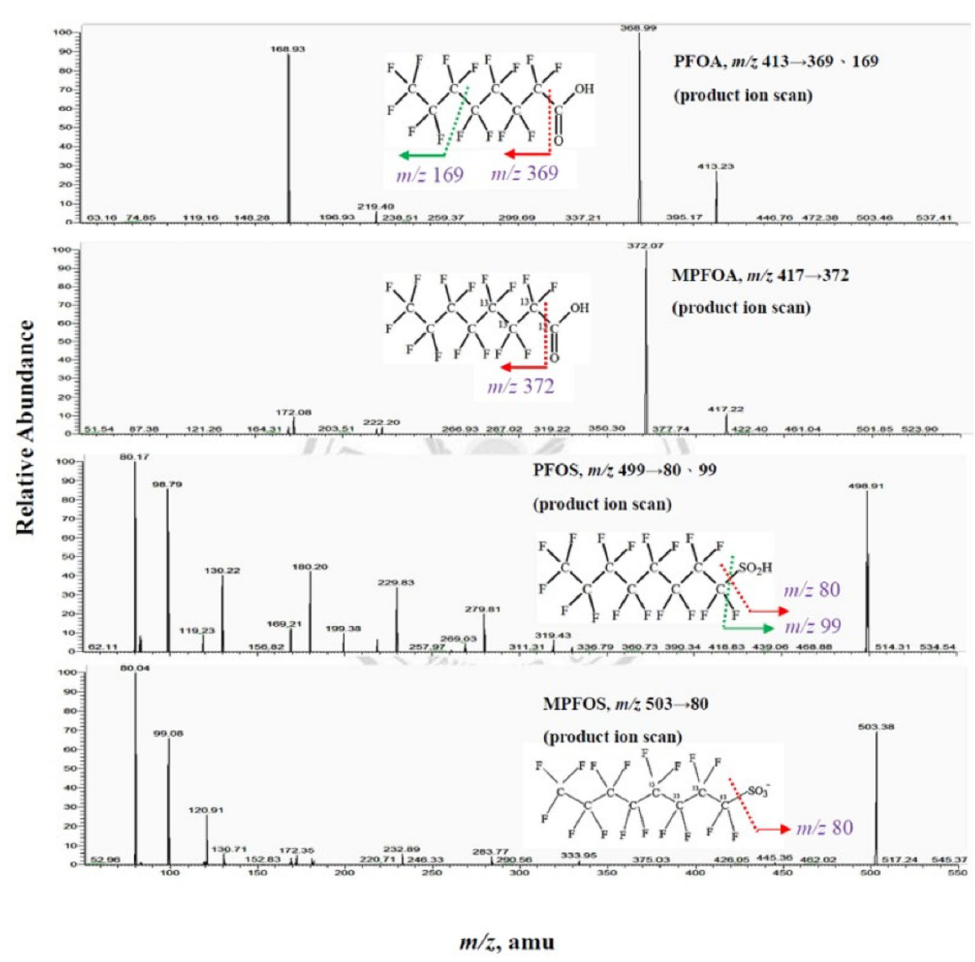
Figure A1. Product ion scan of PFOA and PFOS. Abbreviations: PFOA, perfluorooctanoic acid; MPFOA, monomethyl branch isomer of perfluorooctanoic acid; PFOS, perfluorooctane sulfonate; MPFOS, monomethyl branch isomer of perfluorooctane sulfonic acid.